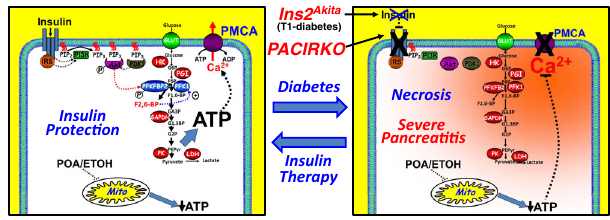
Fig. 10 Cartoon depicting the putative molecular mechanism for insulin protection of pancreatic acinar cells during acute